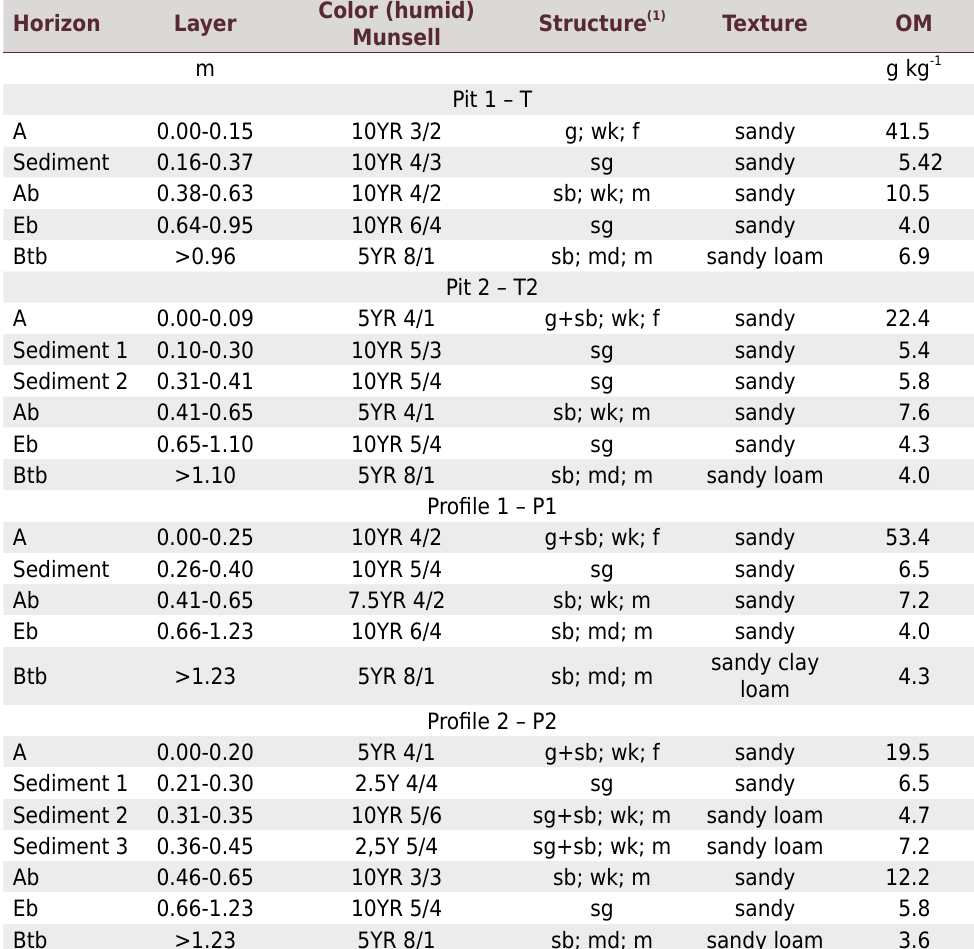
Table 1. Morphological properties and organic matter content (OM) in the soil horizons and sediment layers, described in the pits and profiles Horizon